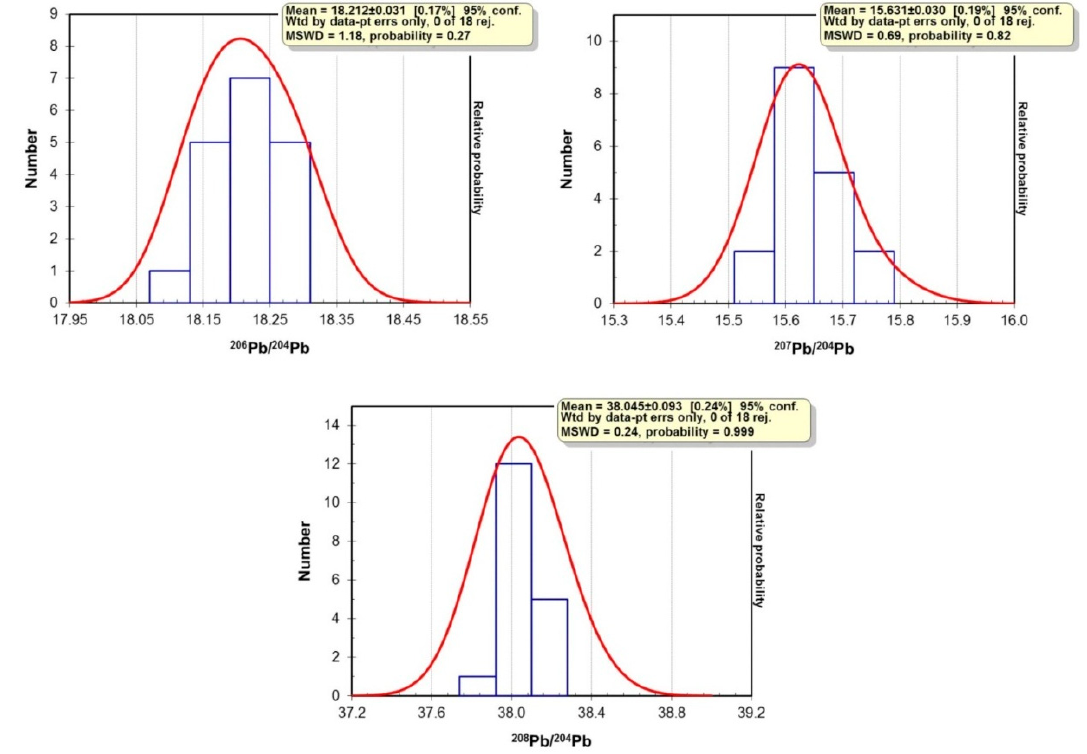
Figure 5. Probability density plots of Pb isotope ratios of galena from the Caribou deposit. MSWD stands for Mean Square Weighted Deviations.